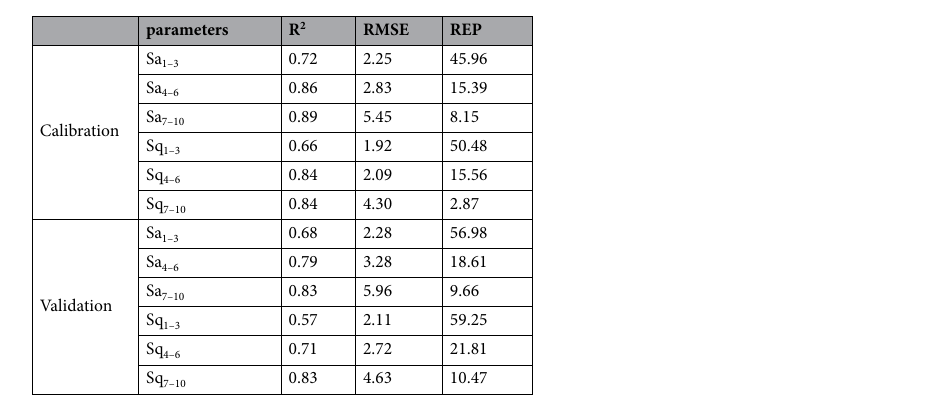
Table 3. Statistics for evaluating the performance of proposed method at different grades of soil in calibration and validation datasets 1–10 are different grades of